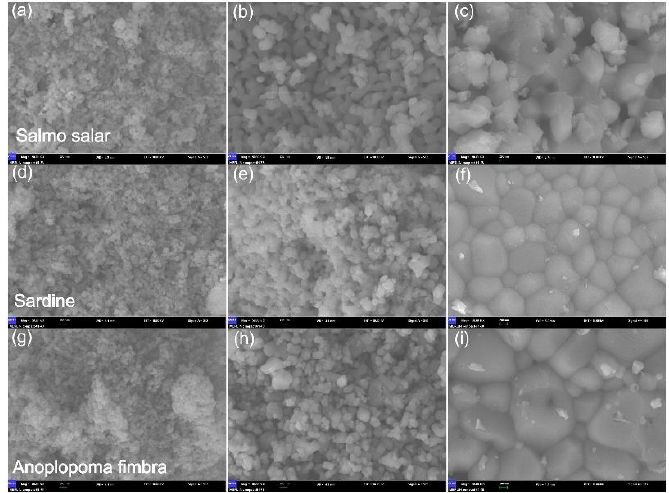
Figure 4. SEM images of BCP powders produced from fishbones at different calcination temperatures: Salmo salar at 700 °C ( a ), 900 °C ( b ), and ( c ) 1100 °C; sardine at 700 °C ( d ), 900 °C ( e ), and ( f ) 1100 °C; and Anoplopoma fimbria at 700 °C ( g ), 900 °C ( h ), and ( i ) 1100 °C. (Magnification bar: 200 nm). Reproduced with permission from [93]. Copyright Elsevier, 2017.